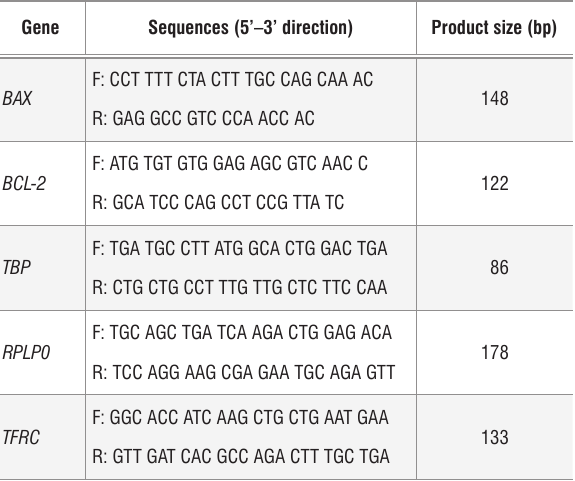
Oligonucleotide sequences used for qPCR Gene Sequences (5’–3’